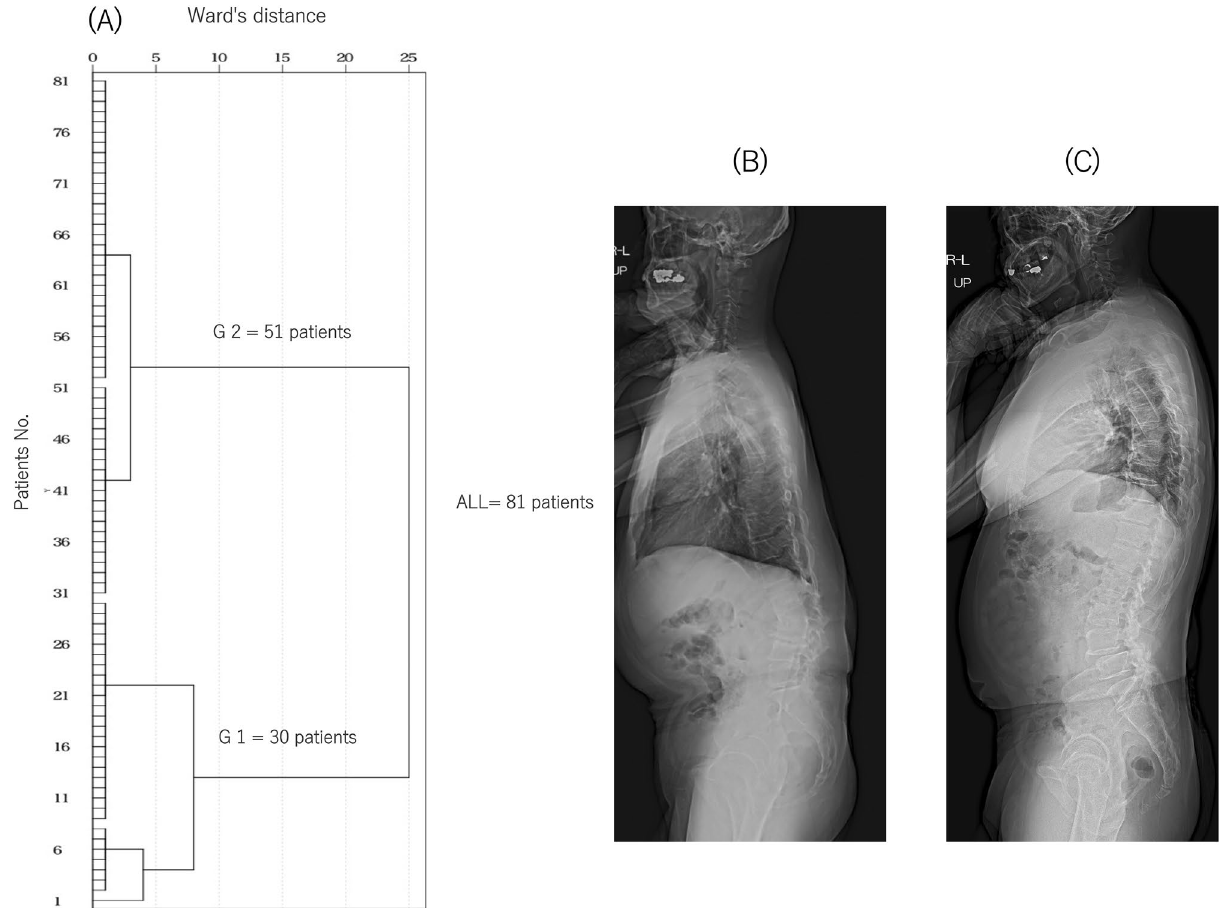
groups 1 (n = 30) and 2 (n = 51) from the cluster analysis. Standing full-length X-ray lateral views of typical cases in groups 1 ( B ) and 2 ( C